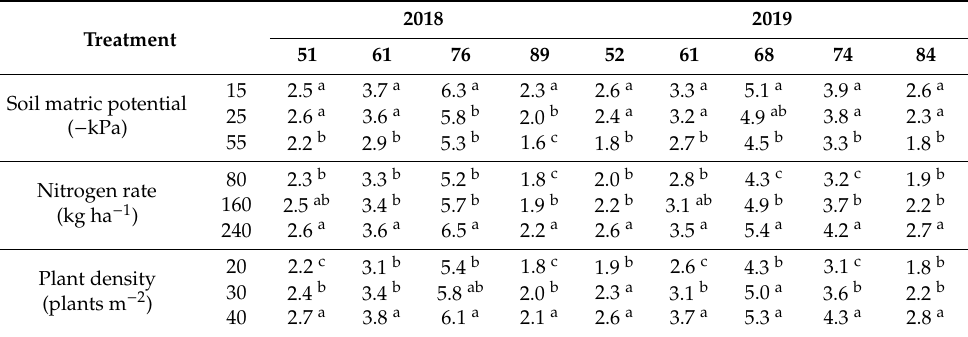
Table 5. E ff ects of soil matric potential, nitrogen application rate, and plant density on quinoa leaf area index (LAI) at 51, 61, 76, and 89 days after sowing (DAS) in 2018 and 52, 61, 68, 74, and 84 DAS in 2019.